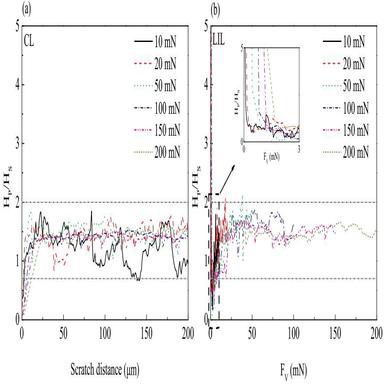
HP/HS ratio along (a) the scratch distance in the CL routine and (b) the vertical load in the LIL routine.